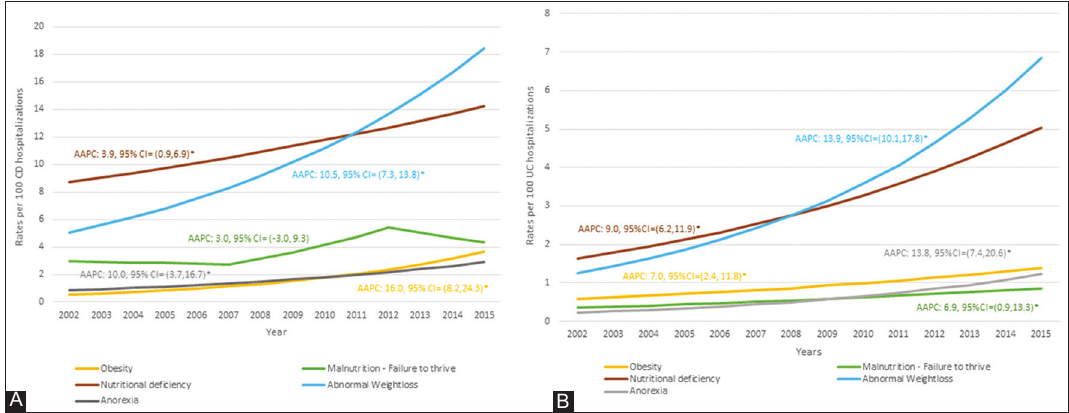
Supplemental Figure 2: Rates of comorbidities per 100 Crohn’s disease [CD] (A) and ulcerative colitis [UC] (B) hospitalizations over the years 2002-2015 AAPC= Average Annual Percent Change.